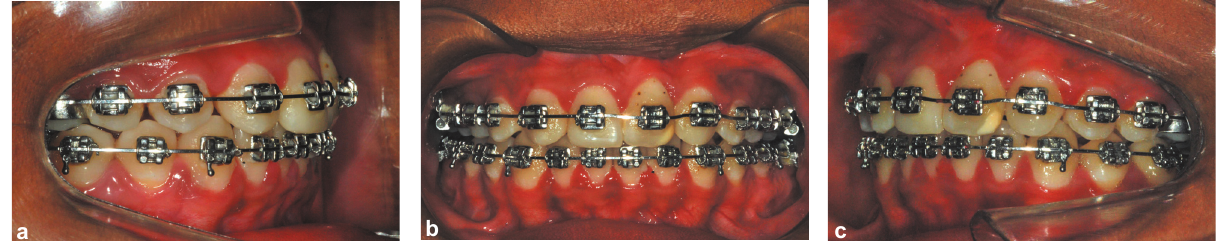
Figure 11- Postoperative intraoral photographs (a) right view (b) frontal view (c) left